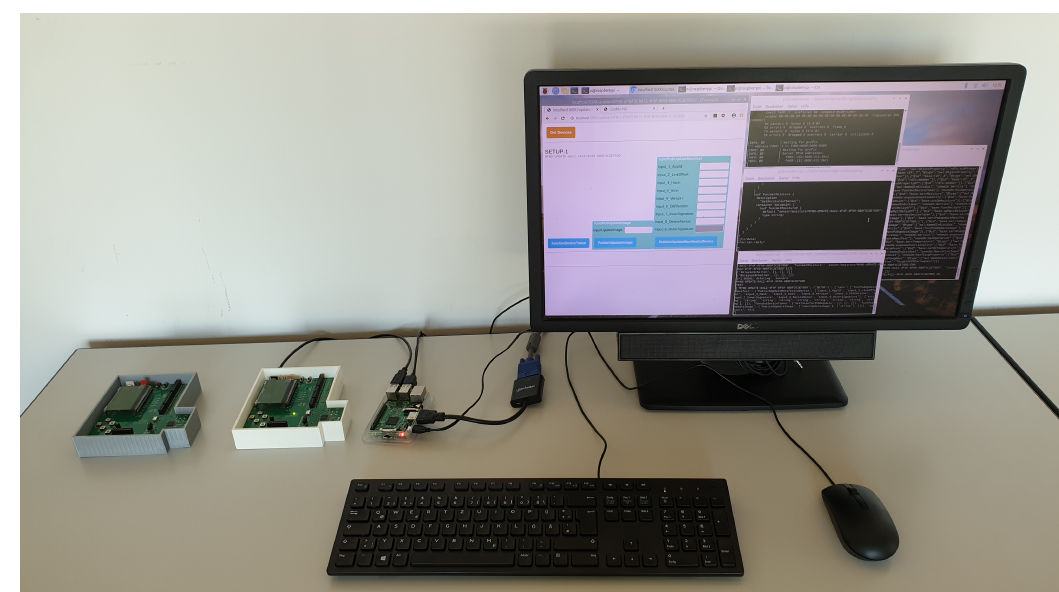
Figure 4. Testbed with a Raspberry Pi 3B and a CC2538dk Development Kit consisting of two CC2538EM microcontrollers plugged into the SmartRF06 Evaluation Boards and used as a 6LowPAN Border Router and an IoT device (wireless and battery-powered) on the left.